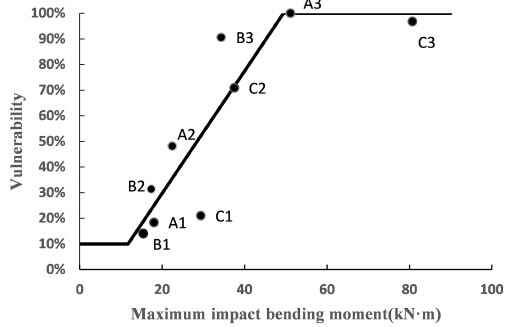
Figure 8. Vulnerability curve with maximum impact bending mo-